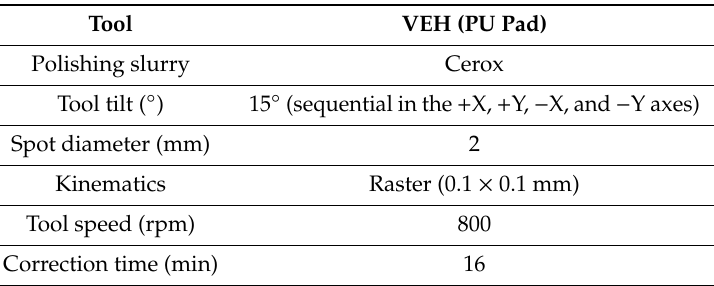
Table 2. 3D correction experiment settings.